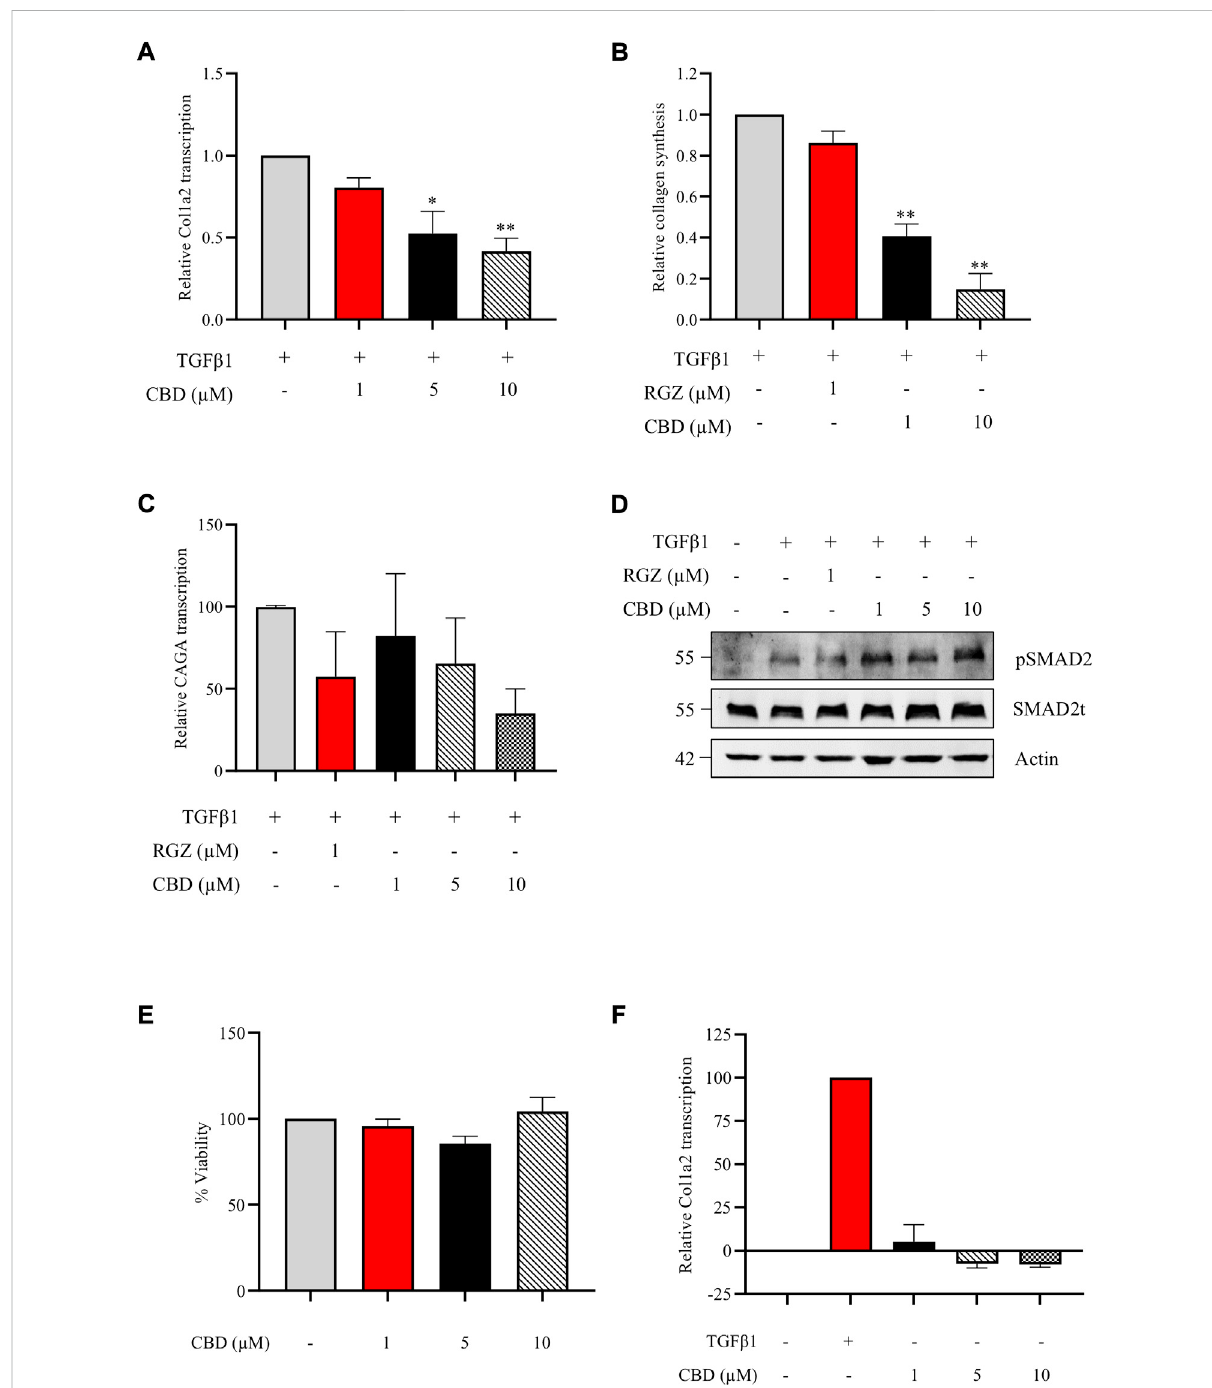
CBD inhibits collagen transcription and synthesis in vitro without altering SMAD2 pathway. (A) Col1a2 transcriptional activity in NIH-3T3 cells pretreated with CBD for 1 h and stimulated with TGF β 1 for the following 24 h (n = 4) (B) Effect of CBD pretreatment on soluble collagen release by human dermal fi broblast using the Sircol Assay. Fibroblasts were pretreated with CBD for 1 h and stimulated with TGF β 1 for 48 h and collagen was measured in the culture media (n = 3). (C) Effect of CBD on SMAD-dependent transcriptional activity. NIH-3T3 cells were transfected with the CAGA-Luc plasmid, preincubated with the indicated concentrations of CBD for 1 h and stimulated with TGF β 1 (10 ng/ml) for 6 h. Then, cells were lysed for luciferase activity ( n = 3). Data are expressed as mean ± S.D. relative to control cells. * p < 0.05; ** p < 0.01; *** p < 0.001 vs TGF β 1-treated cells. (D) CBD effect on SMAD2 phosphorylation. NHDF cells were incubated in low serum conditions (1% FBS) for 24 h. Then cells were pretreated with CBD or Rosiglitazone (RGZ) for 1 h and stimulated with TGF β 1 (10 ng/ml) for 2 h. (E) Viability of NIH3T3 cells treated with different concentrations of CBD after 24 h expressed as percentage taking control as 100% ( n = 3). (F) Effect of CBD treatment on Col1a2 transcriptional activity in NIH-3T3 cells ( n =